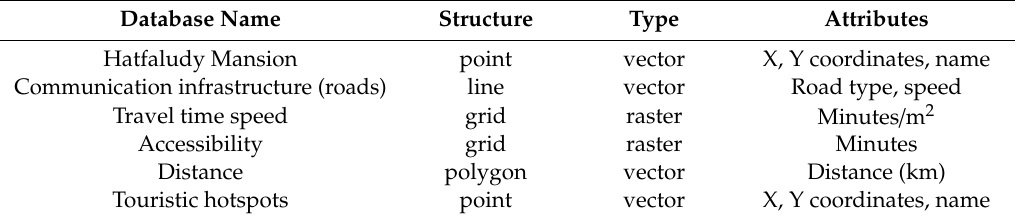
Table 4. Accessibility database structure.